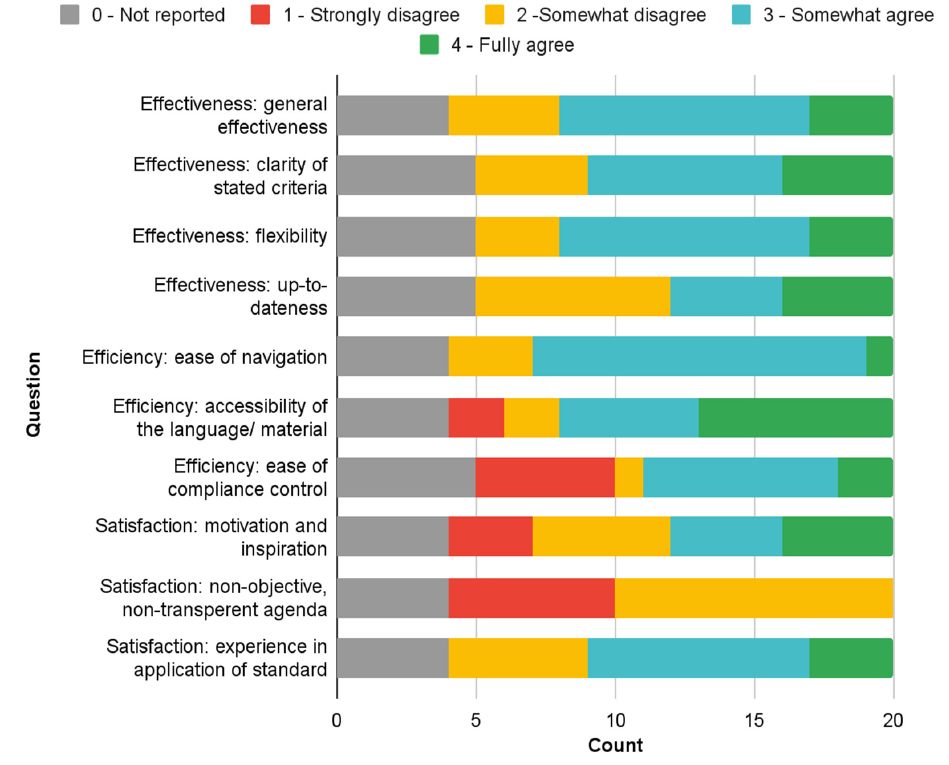
Figure 1. Responses to questions on the usability of the reviewed standards.